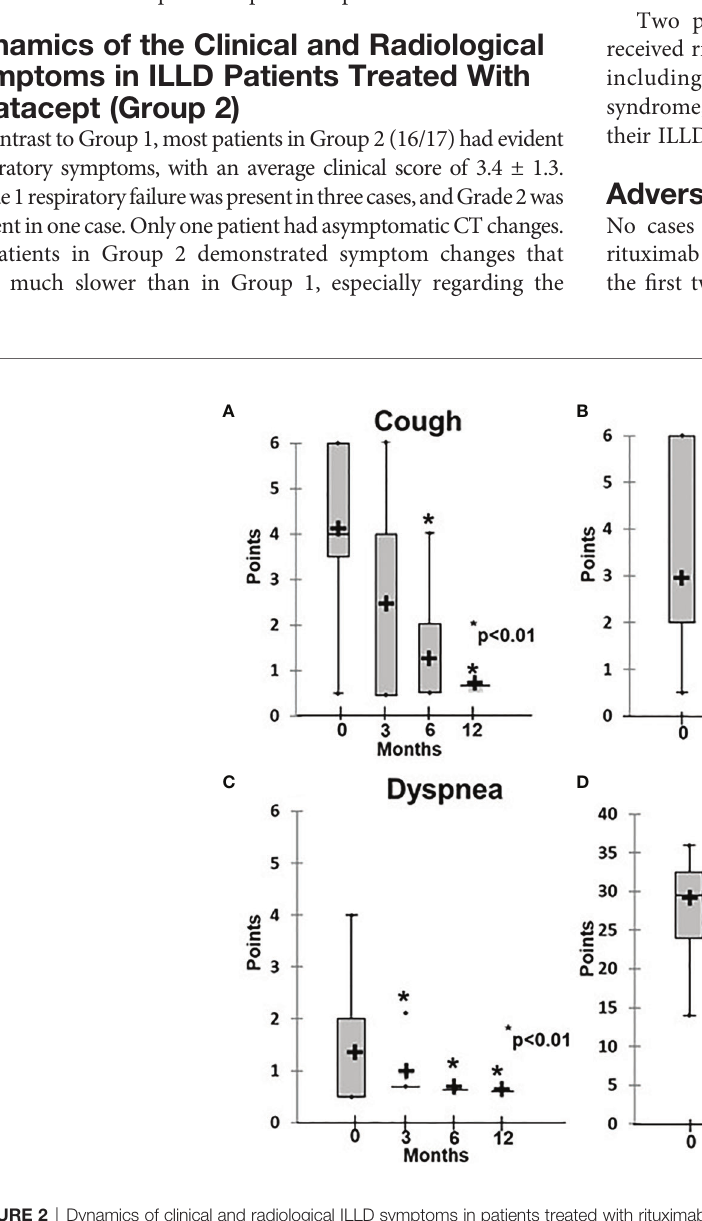
FIGURE 2 | Dynamics of clinical and radiological ILLD symptoms in patients treated with rituximab. (A) Cough, (B) wheezing, (C) dyspnea, (D) CT